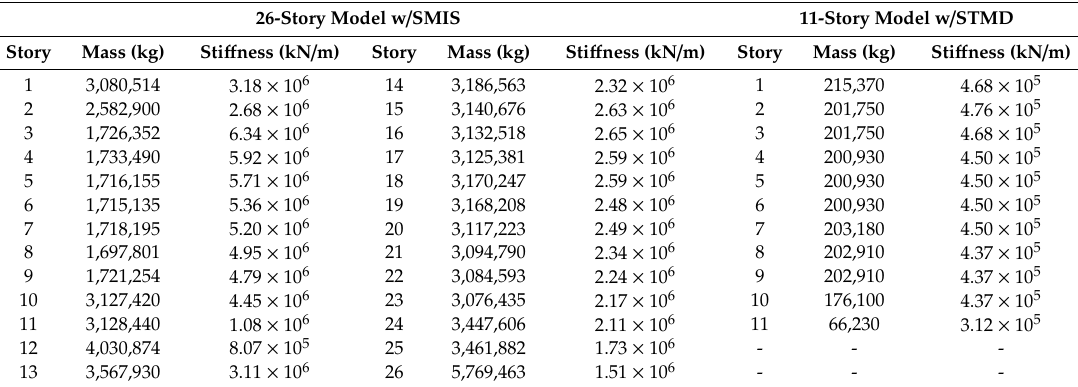
Figure 4. Analytical models of example structures: ( a ) Model with a semi-active tuned mass damper (Example 1); ( b ) Model with a semi-active mid-story isolation system (Example 2). Table 1. Story mass and sti ff ness of the example